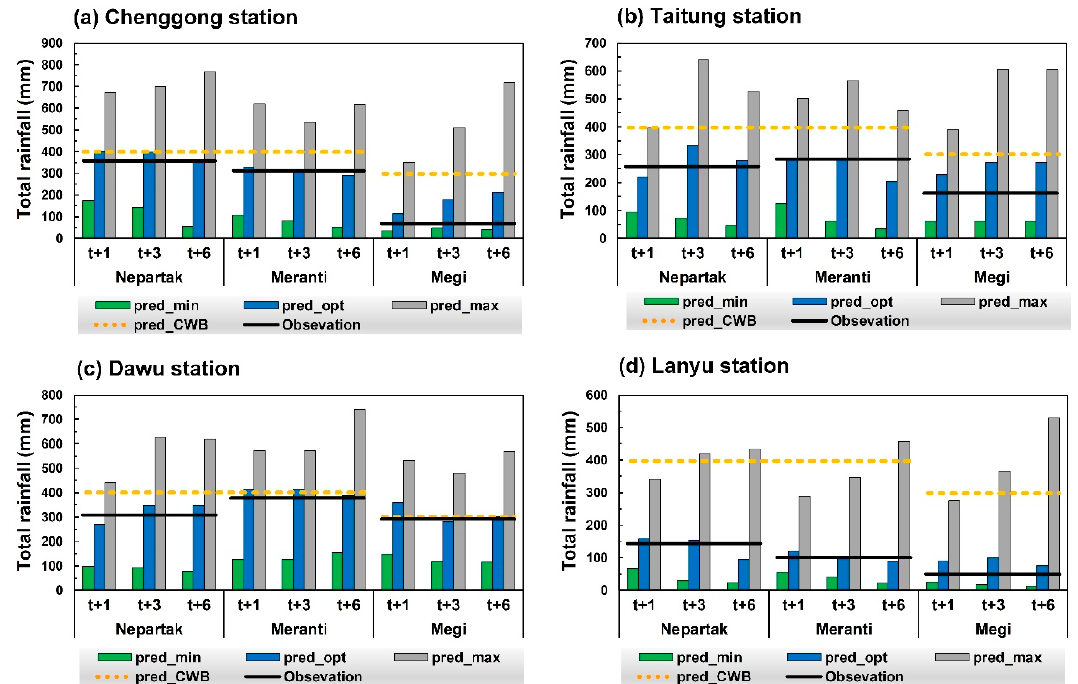
Figure 13. Comparison of observed and predicted total rainfall of test typhoons at each station with CWB nowcasting values: ( a ) Chenggong; ( b ) Taitung; ( c ) Dawu; ( d )